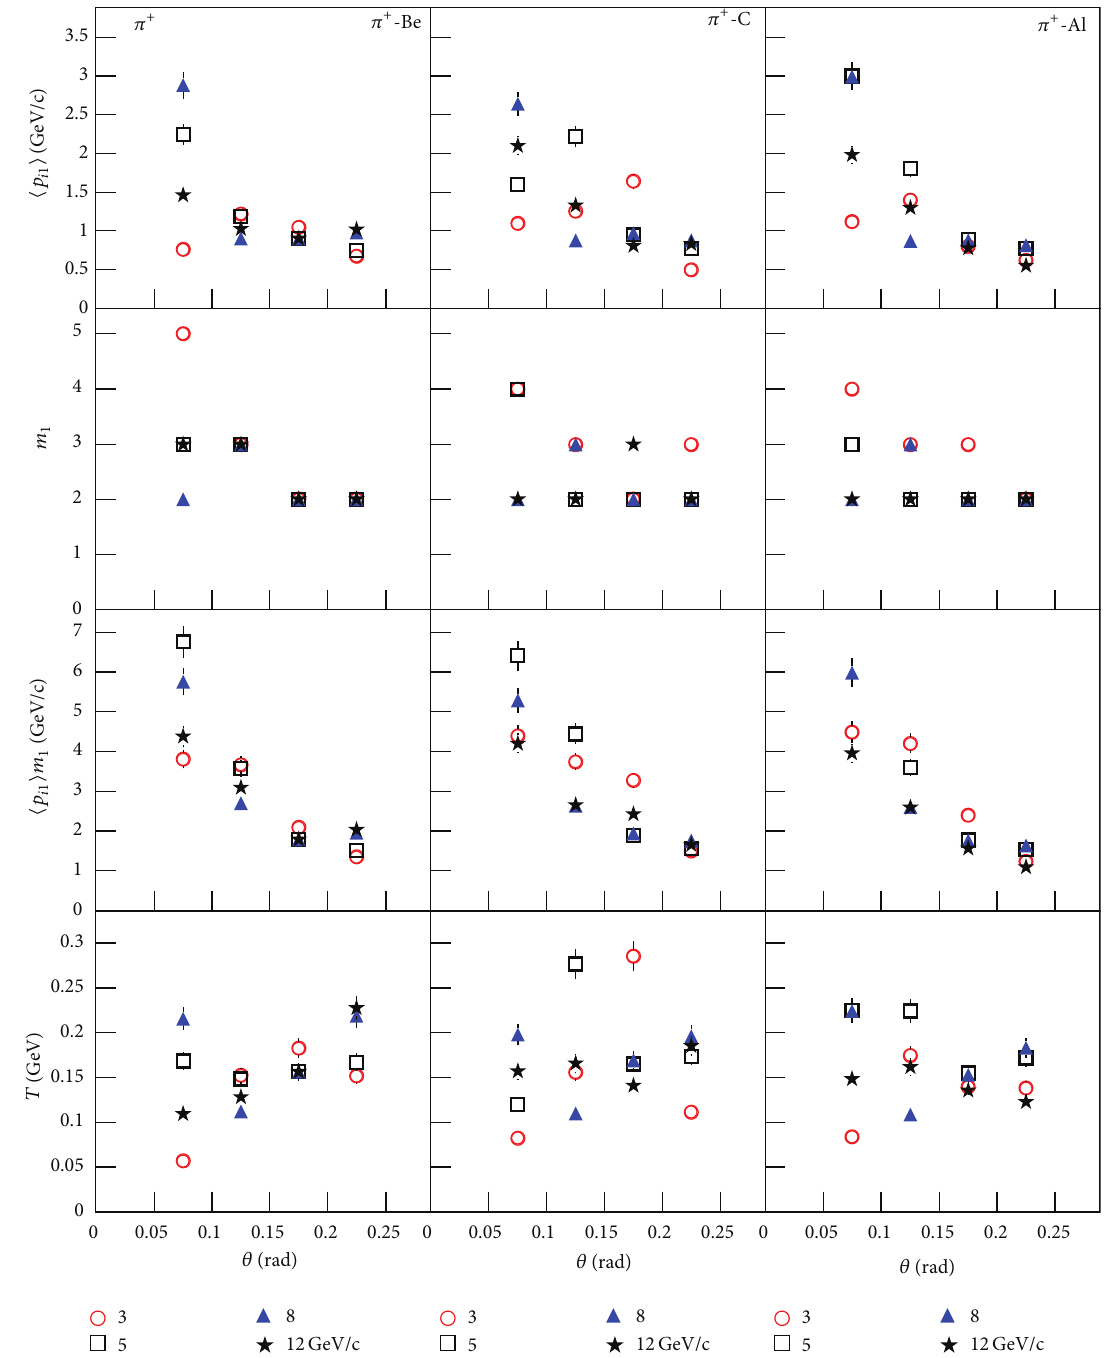
Figure 15: The same as Figure 13, but showing the results for 𝜋 + produced in 𝜋 + -Be, C, and Al interactions. The parameter values for targets Be, C, and Al are taken from Figures 3, 7, and 11,